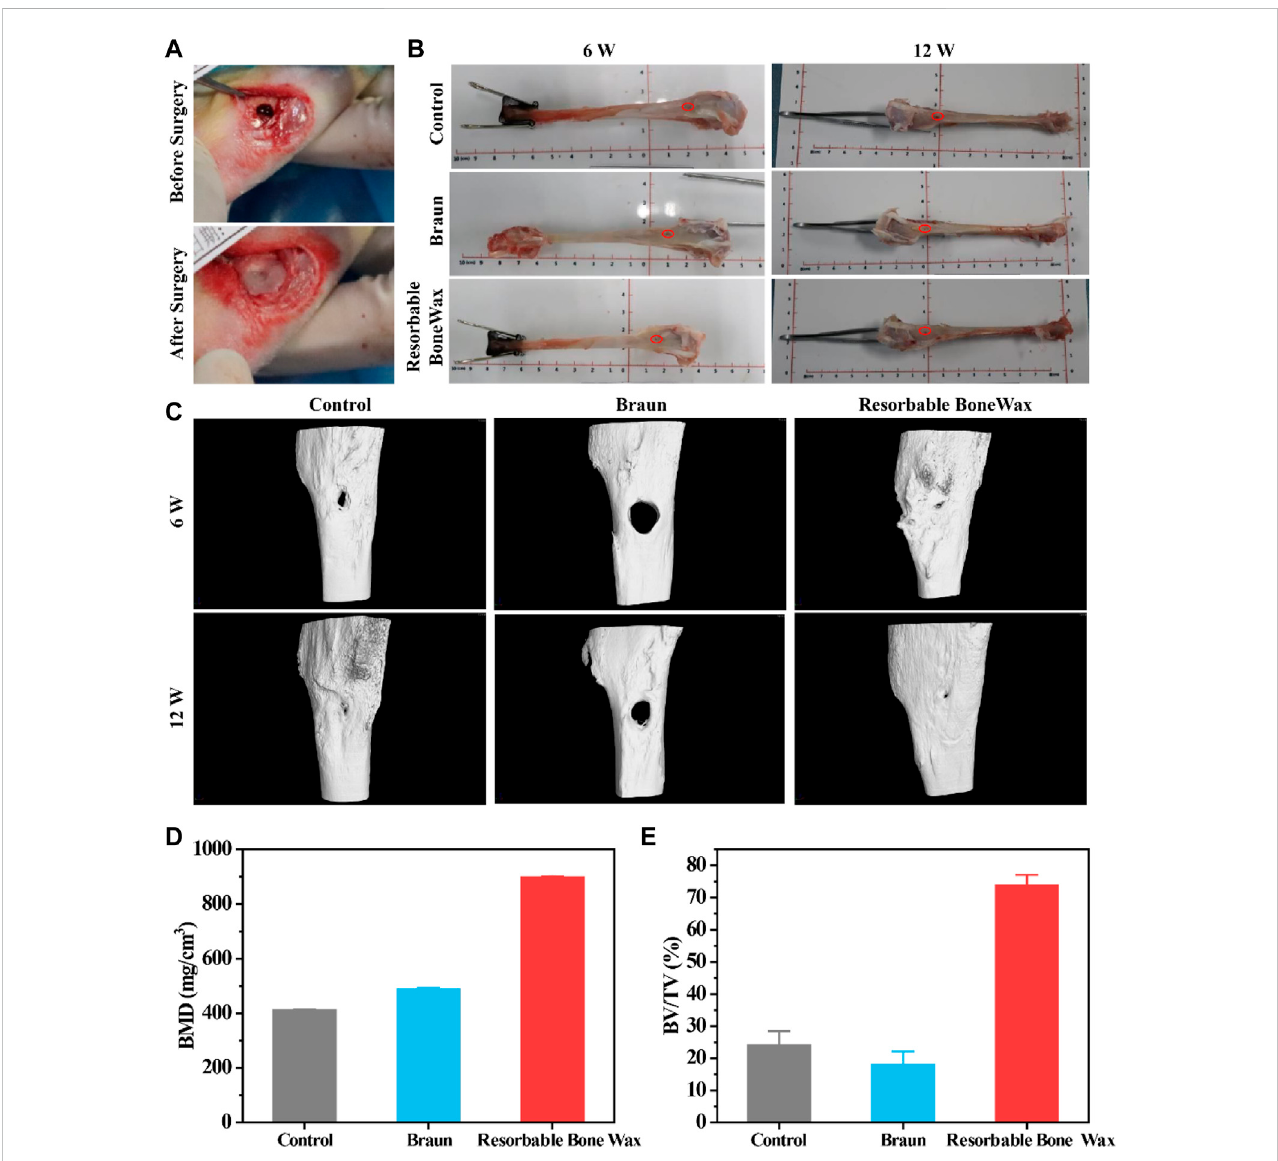
FIGURE 4 In vivo bone formation ability assessment (A) Surgical procedure for tibial injury and bone wax application. (B) Images of tibia 6 and 12 weeks after surgery. (C) Micro-CT images of tibia 6 and 12 weeks after surgery. (D) Statistical calculation of bone density from CT. (E) Statistical calculation of BV/TV from CT.